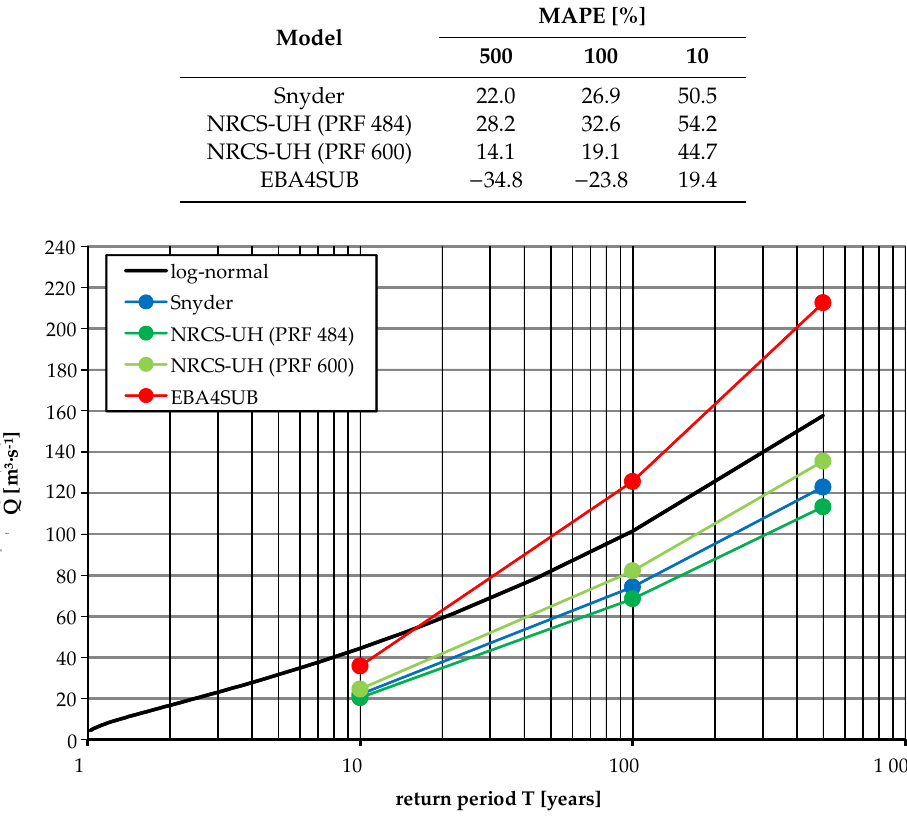
Table 4. Mean Absolute Percentage Error (MAPE) index values for the hydrological models analyzed.